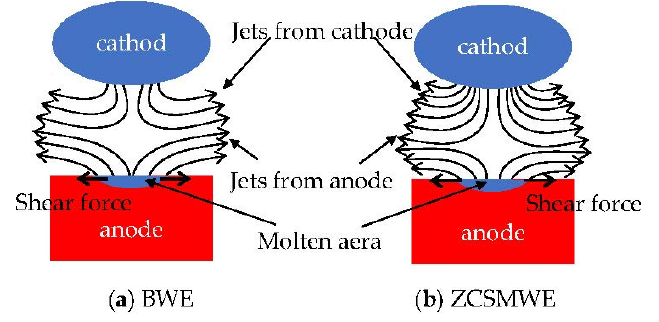
Figure 9. Interaction of jets under BWE and ZCSMWE.